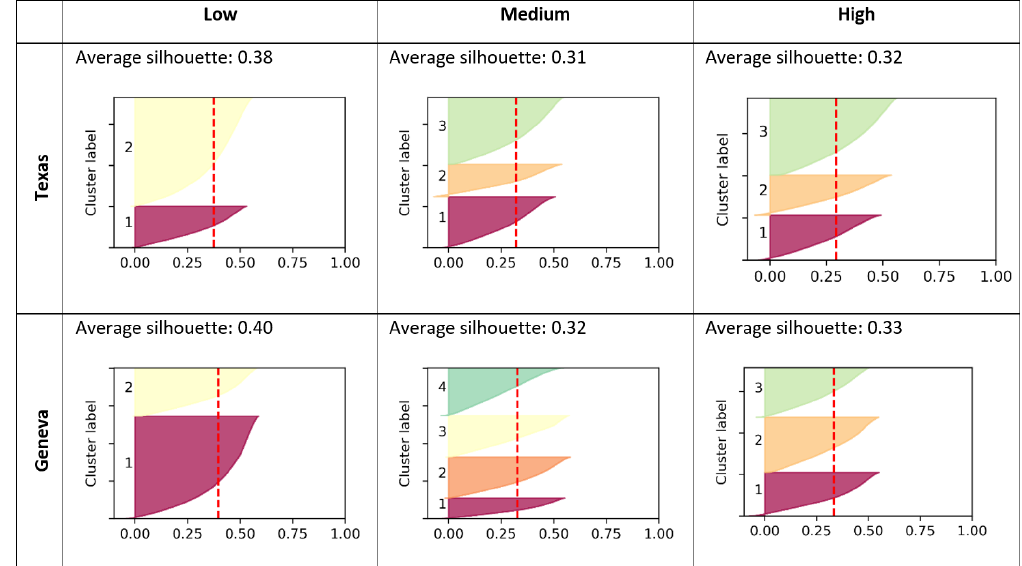
Figure 5. Silhouette analysis for k-means clustering using the daily profile features (optimum number of clusters, k = 2 for Texas low; k = 3 for Texas-medium; k = 3 for Texas-high and k = 2 for Geneva low; k = 4 for Geneva-medium; k = 3 for